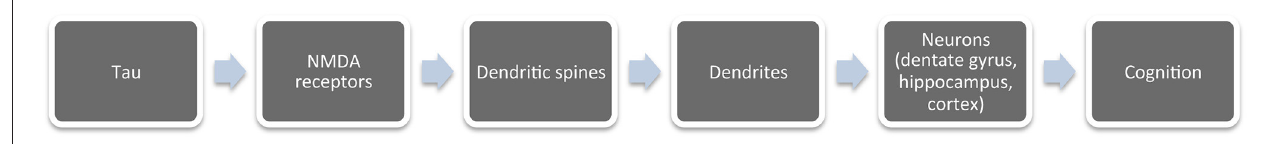
Figure 4 indicates the different levels at which to analyze aging: the whole organism, brain regions, neurons, dendritic spines, NMDA receptors, and cytoskeleton, mainly tau